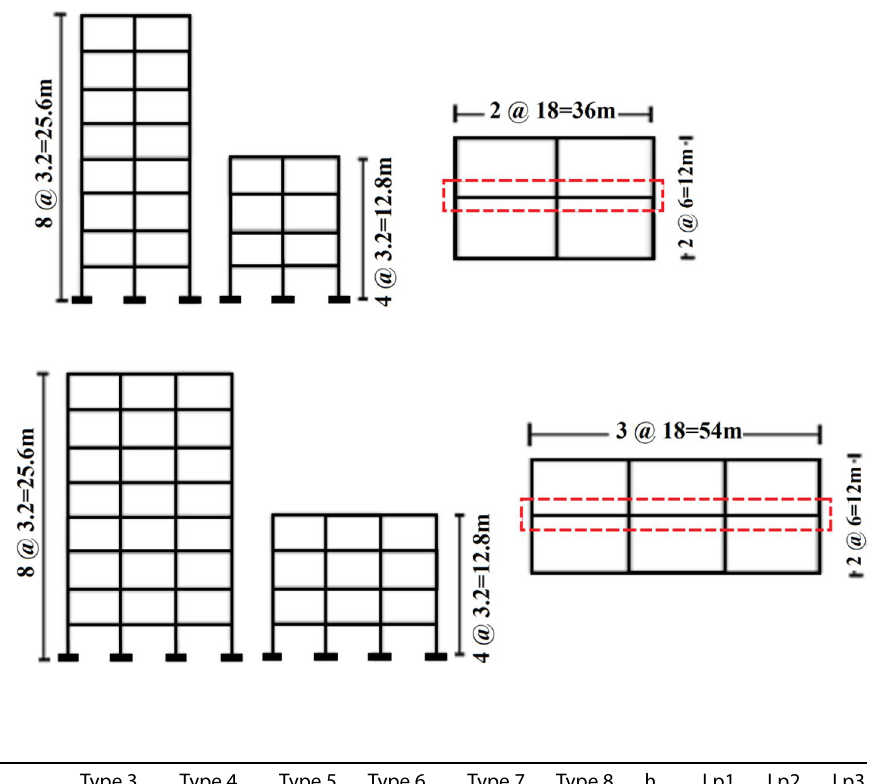
Fig. 5 Plan and view of the studied models